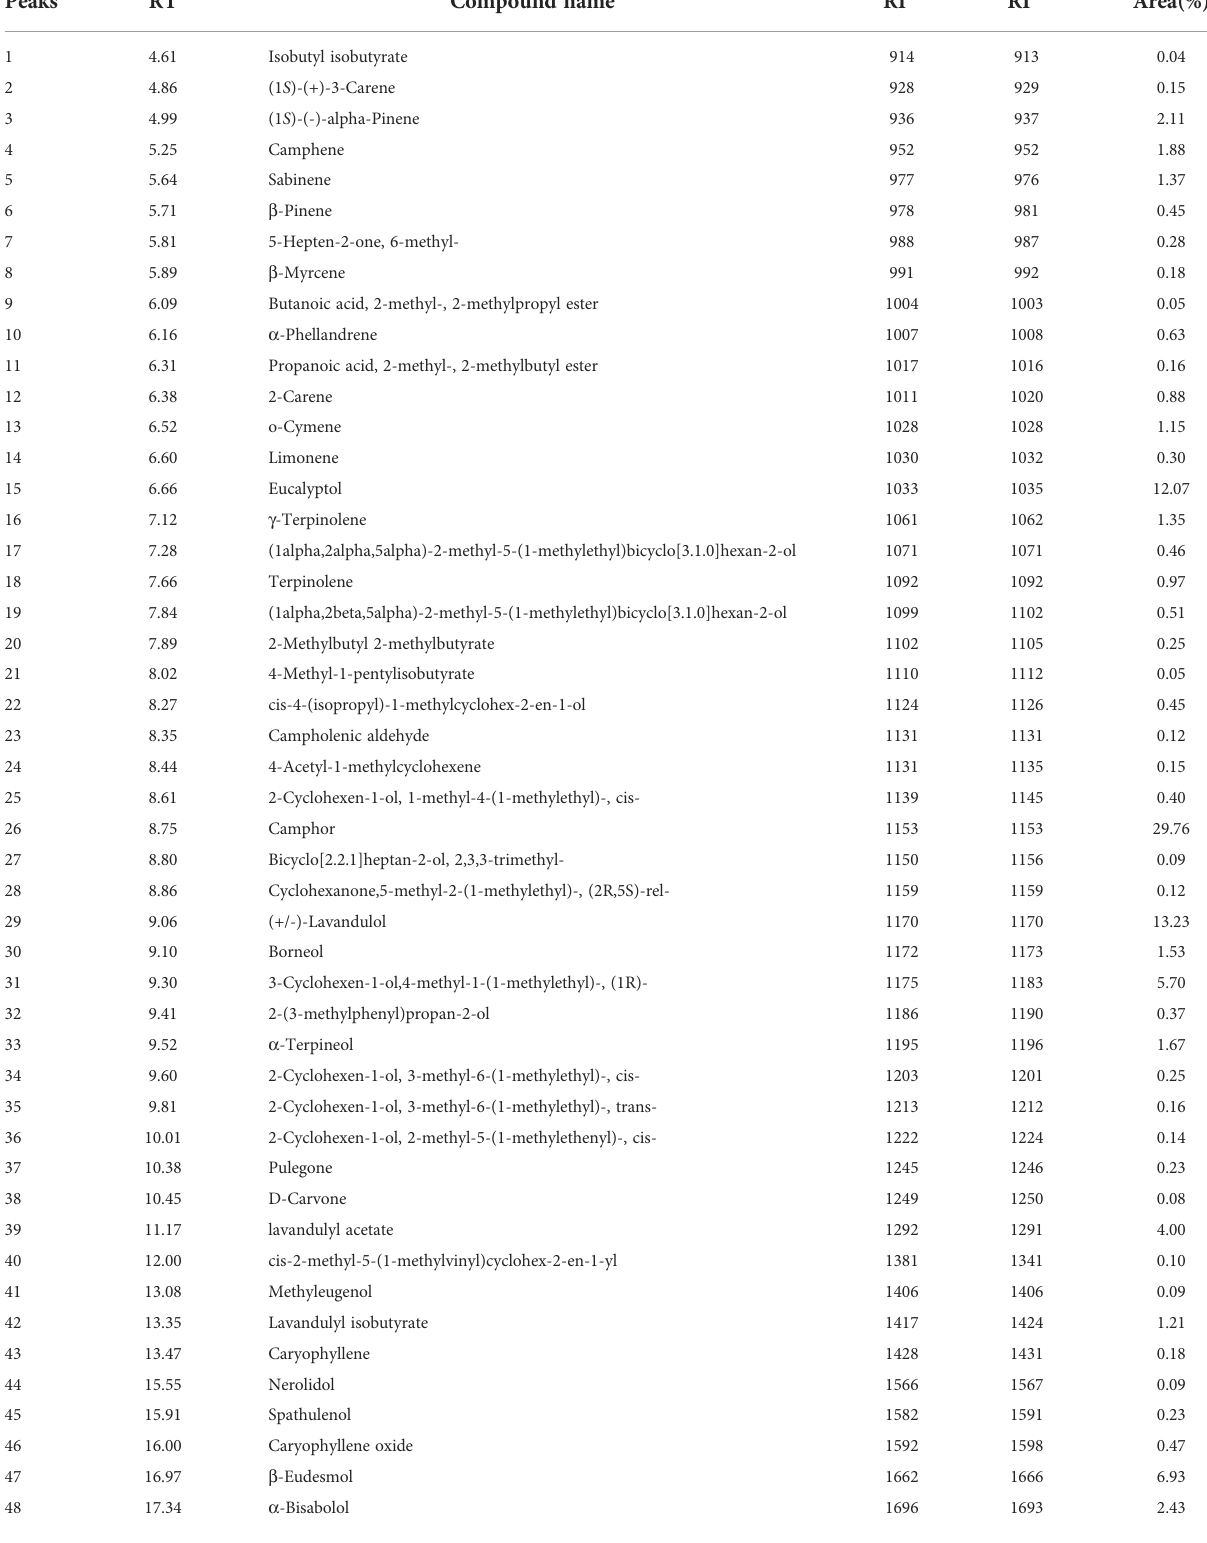
TABLE 1 The chemical pro fi le of A. tibetica EO.